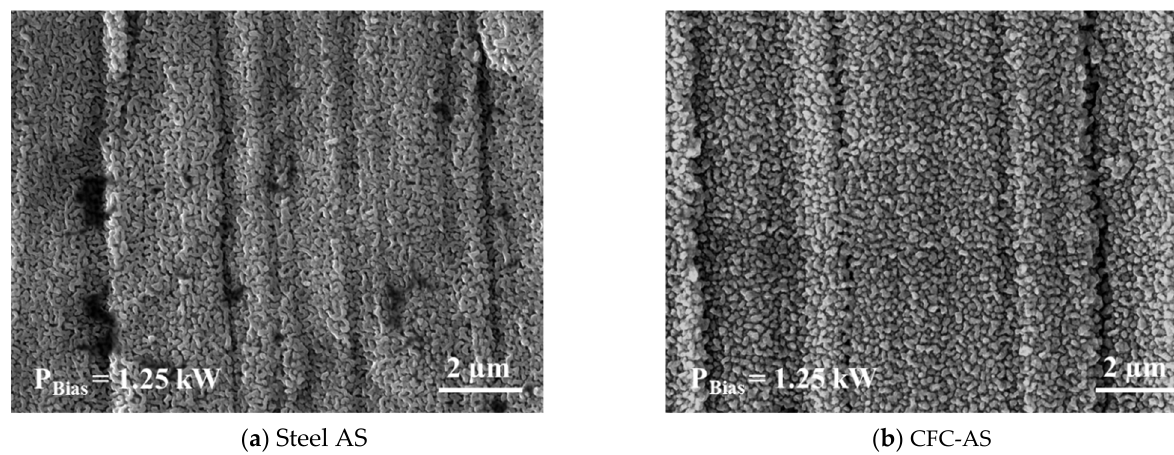
Figure 12. Top-view SEM images of samples after ASPNC treatment for a steel AS ( Φ CH4 = 4 slh) ( a ) and a CFC-AS ( b ) at H 2 :N 2 = 1:1, p = 3 mbar, T = 460 °C, Φ Total = 80 slh, P Bias = 1.25 kW, and t = 5 h.